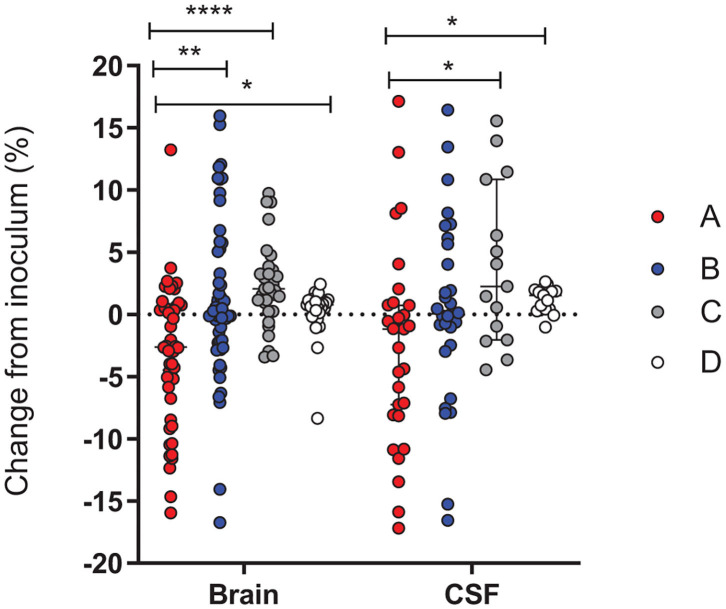
Change in the proportion of PV RMS alleles between the 2 variants inoculums and in vivo samples. Results were pooled from seven independent experiments and each variant is independently calculated as a percentage change from the initial inoculum for that experiment. The relative proportions of hsdS variants A (red), B (blue), C (gray) and D (white) between the inoculum and the bacteria harvested in In vivo CSF and cerebellum samples. A Kruskal-Wallis test showed that the proportion of the A variant is repeatedly reduced in comparison to the starting inoculum, while the C (CSF and brain) and B (brain) variants increase. p < 0.05 (*), p < 0.01 (**), and p < 0.0001 (****).